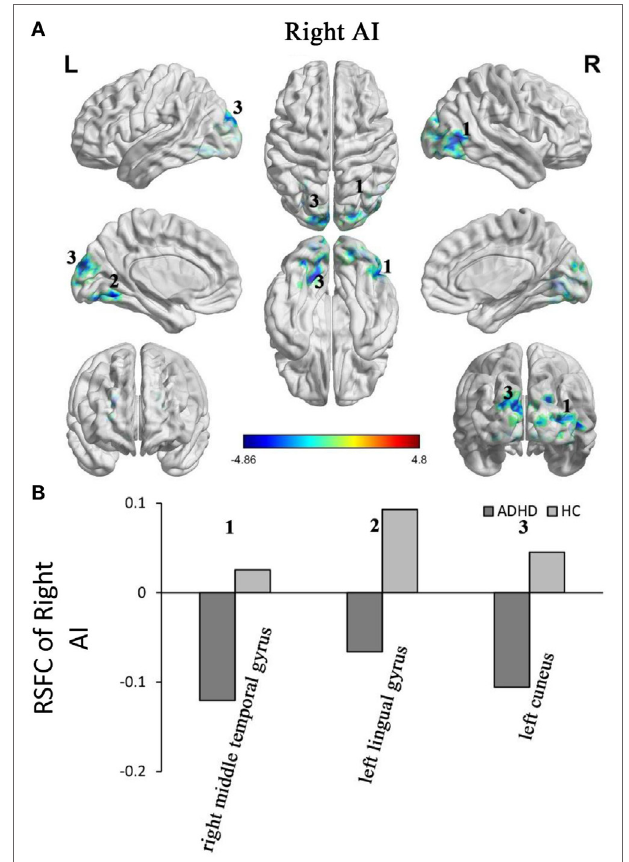
FigUre 3 | Group differences in the RSFC of the right AI. Yellow color (ADHD > HC) indicates an increased functional connectivity with the insular subregions in the ADHD group and blue color (ADHD < HC) indicates a decreased functional connectivity. (a) The clusters show significant differences in the RSFC of the left AI between the two groups. (B) Mean functional connectivity z -scores in clusters showing significant differences in the RSFC between the ADHD and HC groups. Numbers 1–5 marked in (a) refer to the brain regions in (B) . RSFC, resting-state functional connectivity; AI, anterior insula; HC, healthy control; ADHD, attention deficit/ hyperactivity disorder.